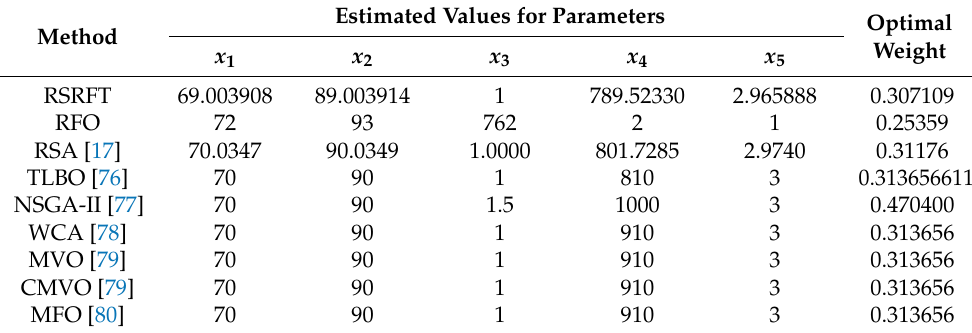
Table 6. The value of the estimated parameters using RSRFT to solve the multiple disc clutch brake